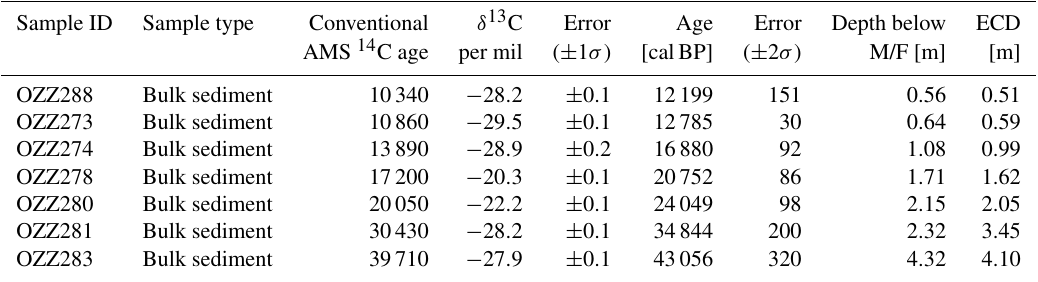
Table 3. AMS radiocarbon ages from the Onepoto maar lake sediment record. Ages calibrated against SHCal20 (Hogg et al., 2020) in